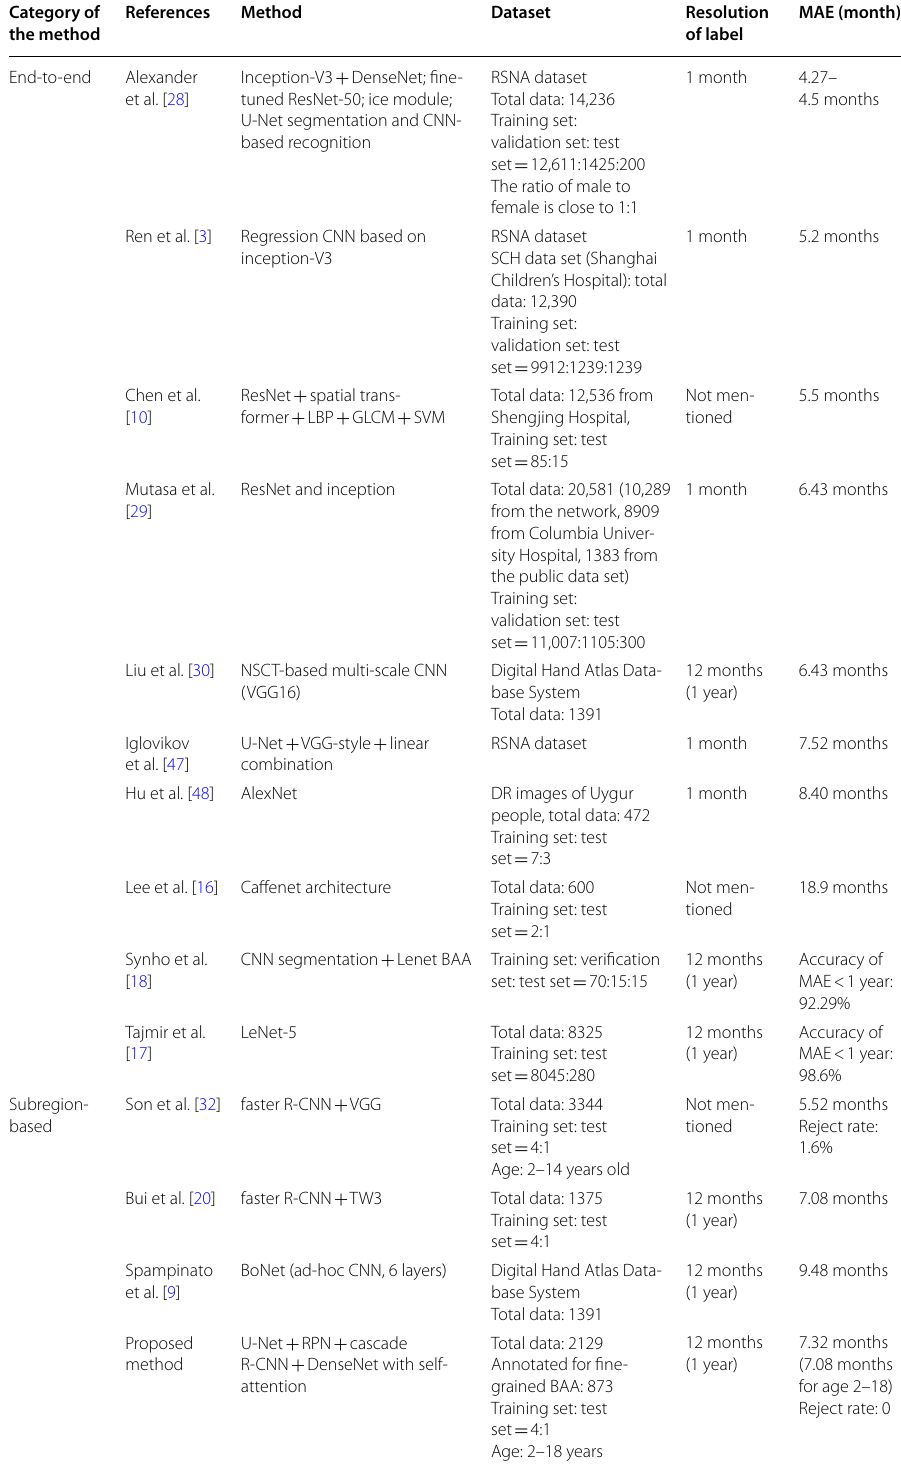
Table 3 Summary of the bone age testing methods based on deep learning Category of the method